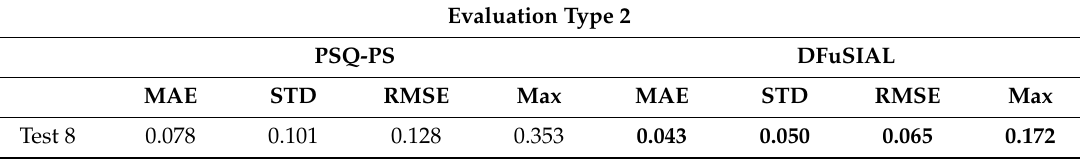
Table 5. Average values obtained by evaluation type 2 of HRS fraction values obtained in Experiment 3 (Test 8) by PSQ-PS and the proposed fusion method DFuSIAL, with respect to the LSR fractions obtained by